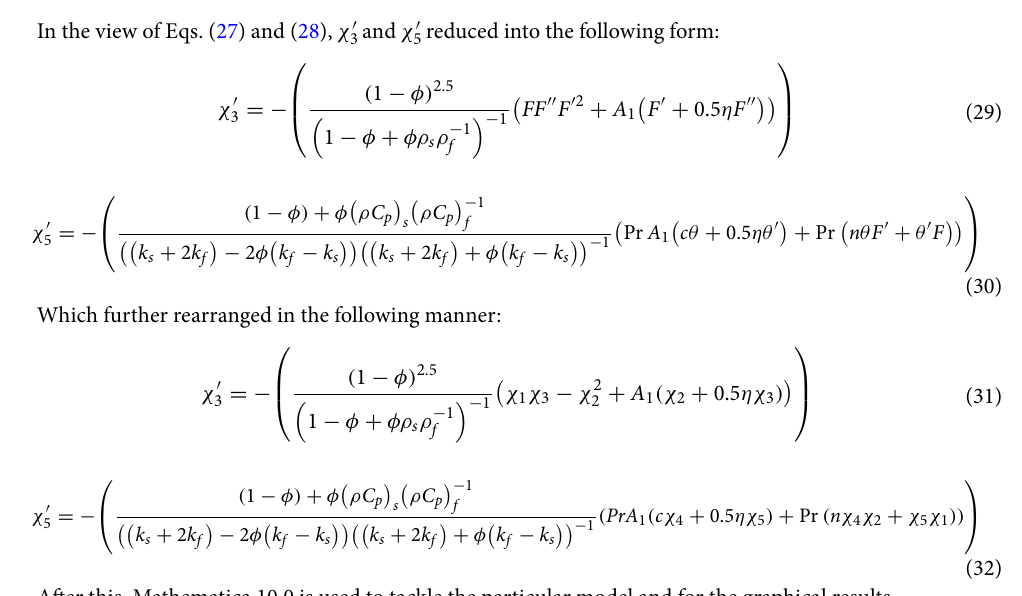
Figure 2. The velocity against ( a ) Suction and ( b )